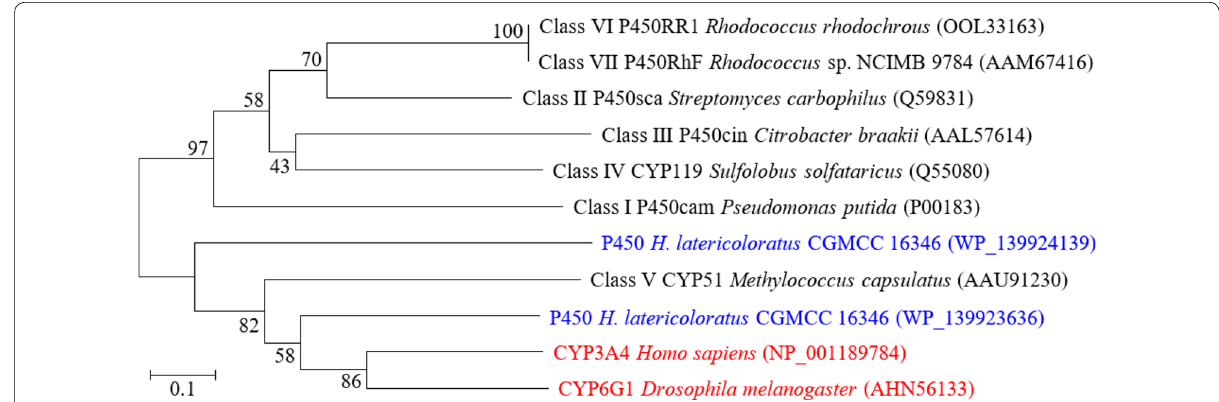
Fig. 7 Neighbor-joining phylogenetic tree based on bacterial CYP450, human CYP3A4 and fruit fly CYP6G1 sequences. Human CYP3A4 and fruit fly CYP6G1 were reported to degrade imidacloprid via the hydroxylation pathway (Fusetto et al.